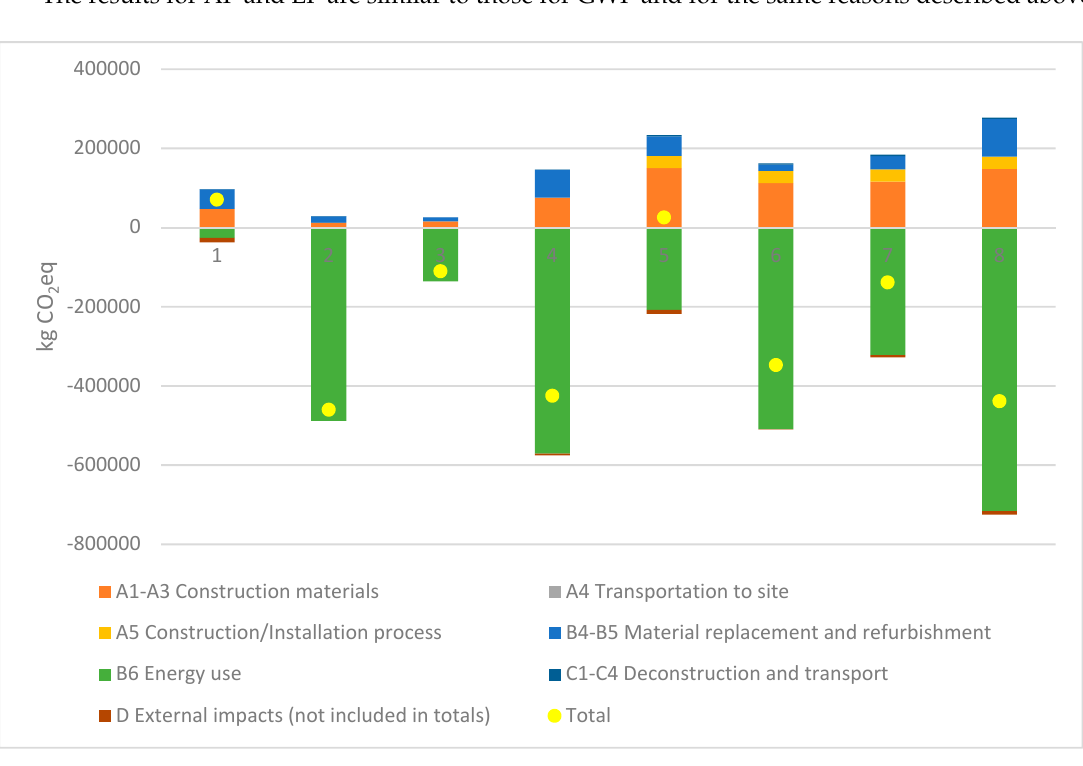
Figure 1. Global Warming Potential (CO 2 eq).